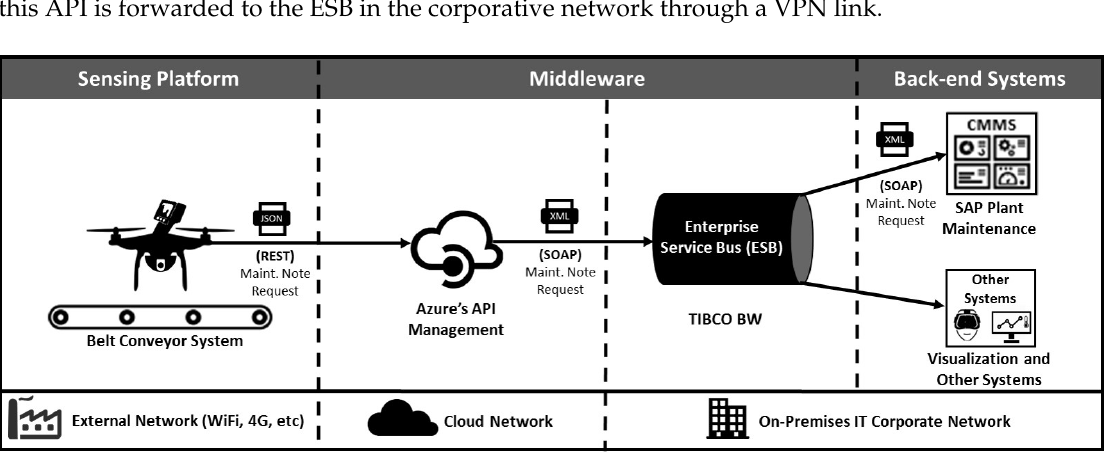
Figure 4. Middleware connectivity and protocol